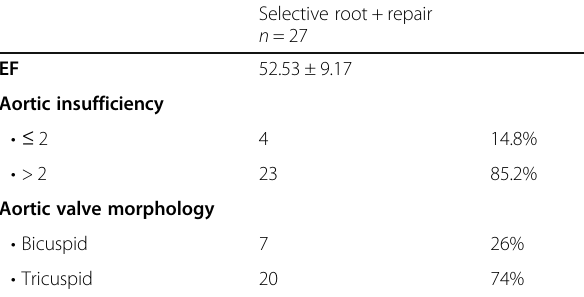
Table 2 Preoperative echocardiographic